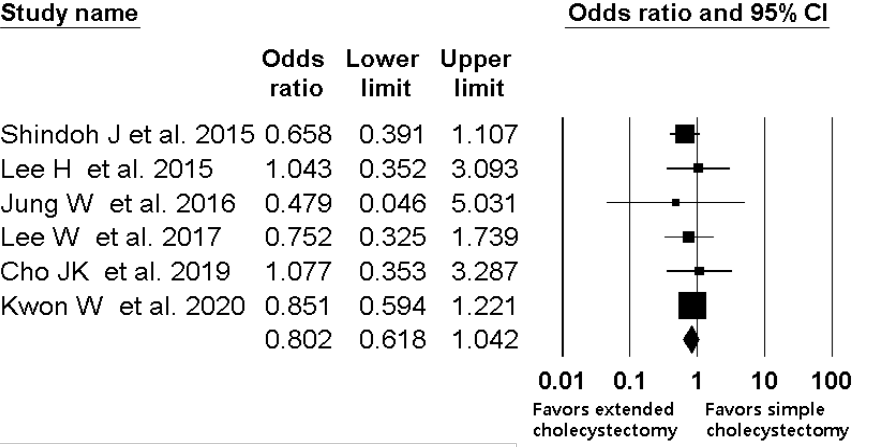
Figure 4. Forest plot of overall survival between extended cholecystectomy and simple cholecystec- tomy in T2b GBC patients. The figure depicts individual trials as filled squares with relative sample size and the 95% confidence interval (CI) of the difference as a solid line. The diamond shape indi- cates the pooled estimate and uncertainty for the combined effect. 3.5. Lymph Node Metastasis A total seven studies reported lymph node metastasis [1–7]. Of the 1728 patients, lymph node metastasis occurred in 539 patients (31.2%). The rate of lymph node metasta- sis was lower in the T2a group (26.6%) compared with that in the T2b group (36.6%) (Odds ratio (OR), 2.164; 95% CI, 1.309 to 3.575; number needed to treat (NNT), 3.6; 95% CI, NNT